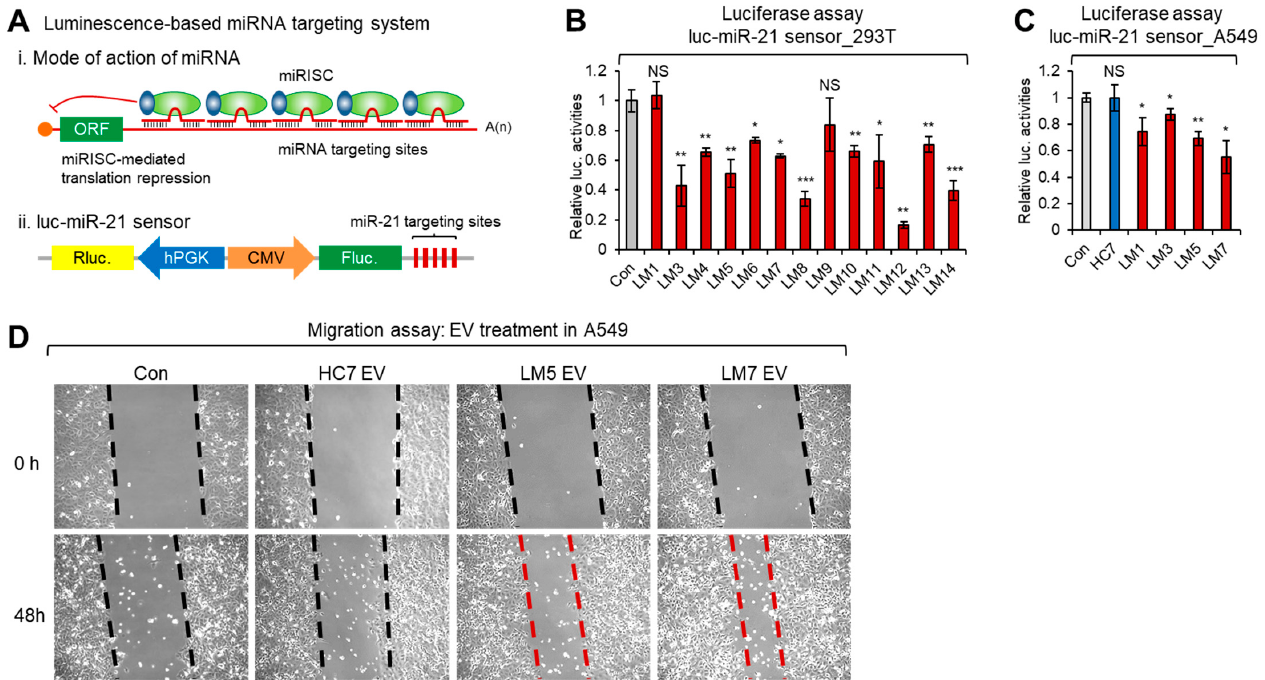
Figure 6. miRNA sensor and cellular migration-based investigation of extravesicular miR-21 functionality of LM patient CSF. ( A ) Mode of action of miRNA targeting (i), and schematic depiction of luminescence-based miR-21 sensor system (ii). miRISC; miRNA-induced silencing complex. ( B,C ) Relative firefly luciferase activities showed inverse correlation with functional miR-21 expression level in CSFs ( B ) and EVs ( C ), which binds to the miRNA targeting sites in 3 ′ UTR of firefly luciferase in each luc-miR-21 sensor-bearing 293T ( B ) and NSCLC A549 ( C ) cells. Renilla luciferase activities were used in normalization of firefly luciferase activities. Data represent the mean values of three independent experiments ( n = 3). Error bars in the graph represent ± standard deviation, and the p -values compare each LM CSF group to medium control (Con). * p < 0.05, ** p < 0.01, *** p < 0.001; NS, not significant. ( D ) Representative images of A549 migration assays after 48 h treatment with EVs from LM CSF (LM5 and LM7) and HC (HC7). Phase contrast microscopy images were taken with Axio Observer (100×, Zeiss).